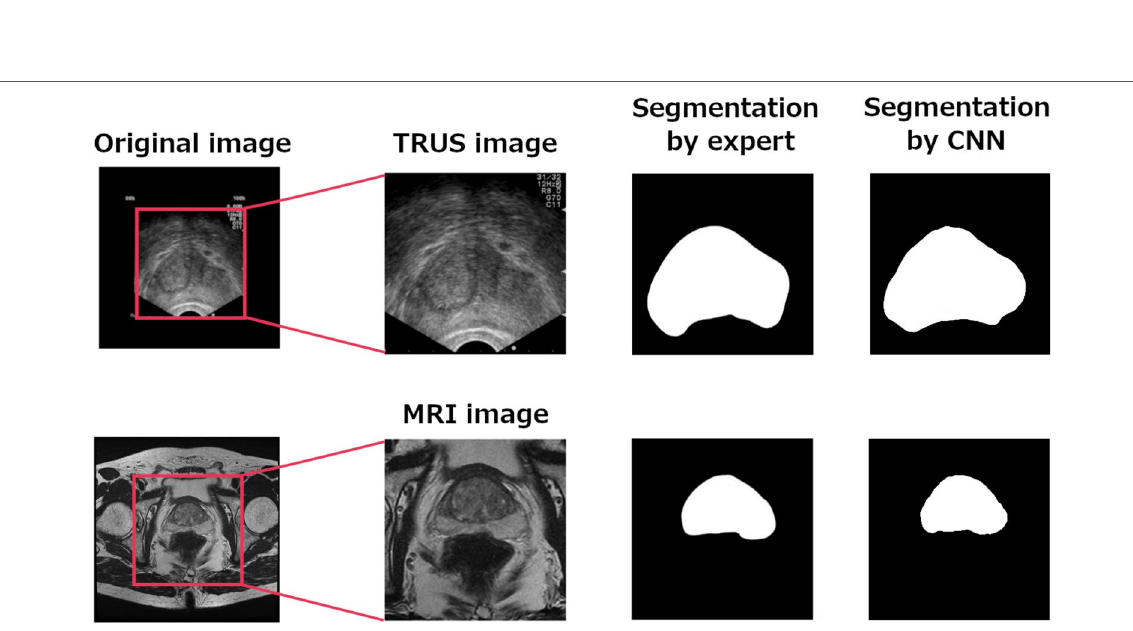
Fig. 3 Overview of the data